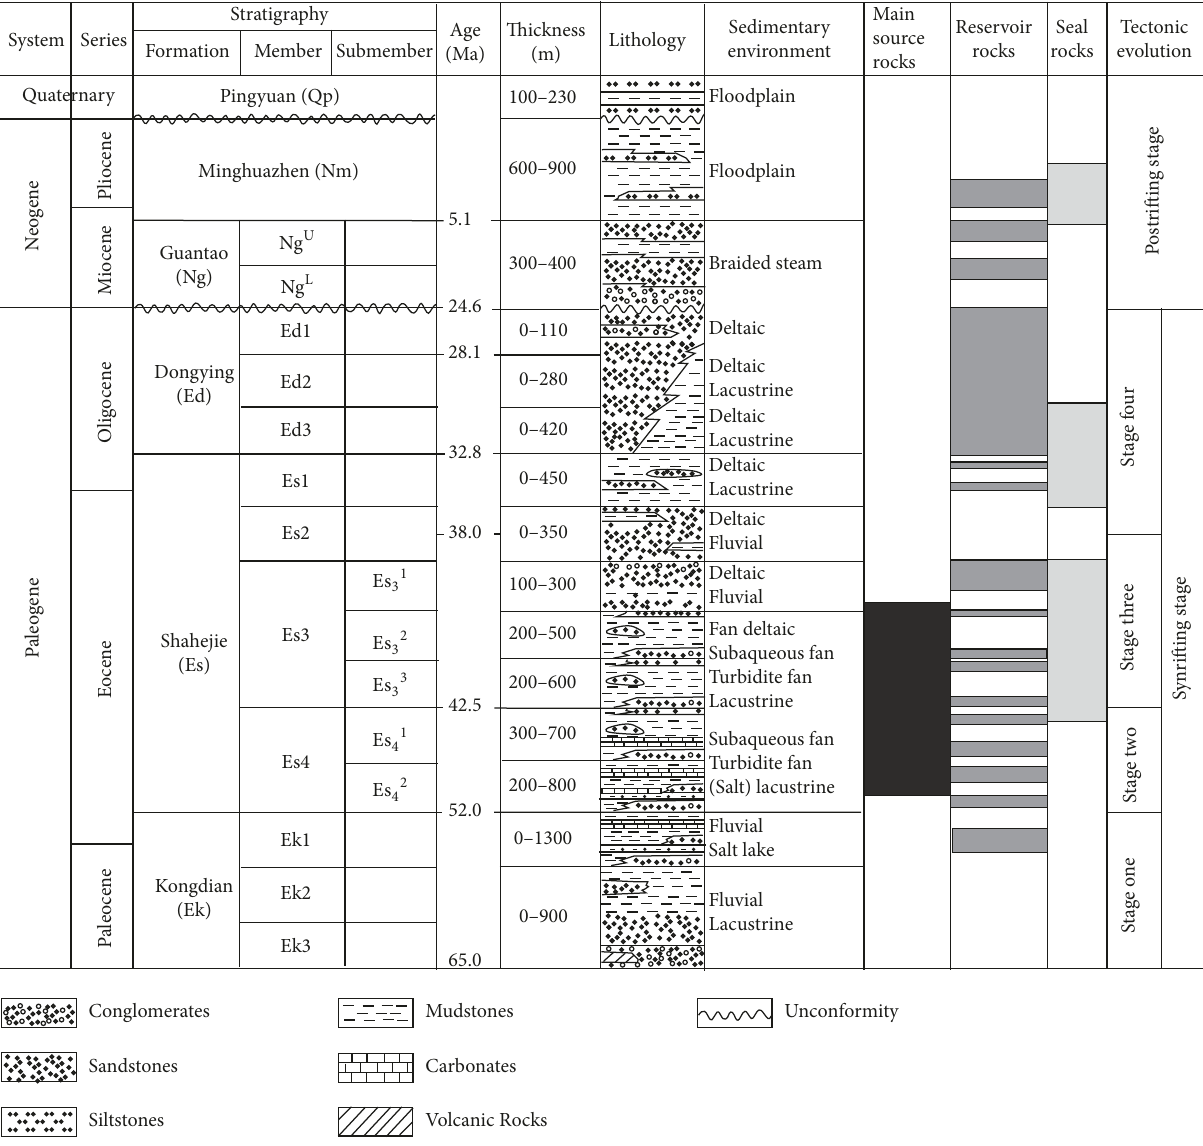
Figure 2: Generalized Cenozoic-Quaternary stratigraphy of the Dongying Sag (modified from